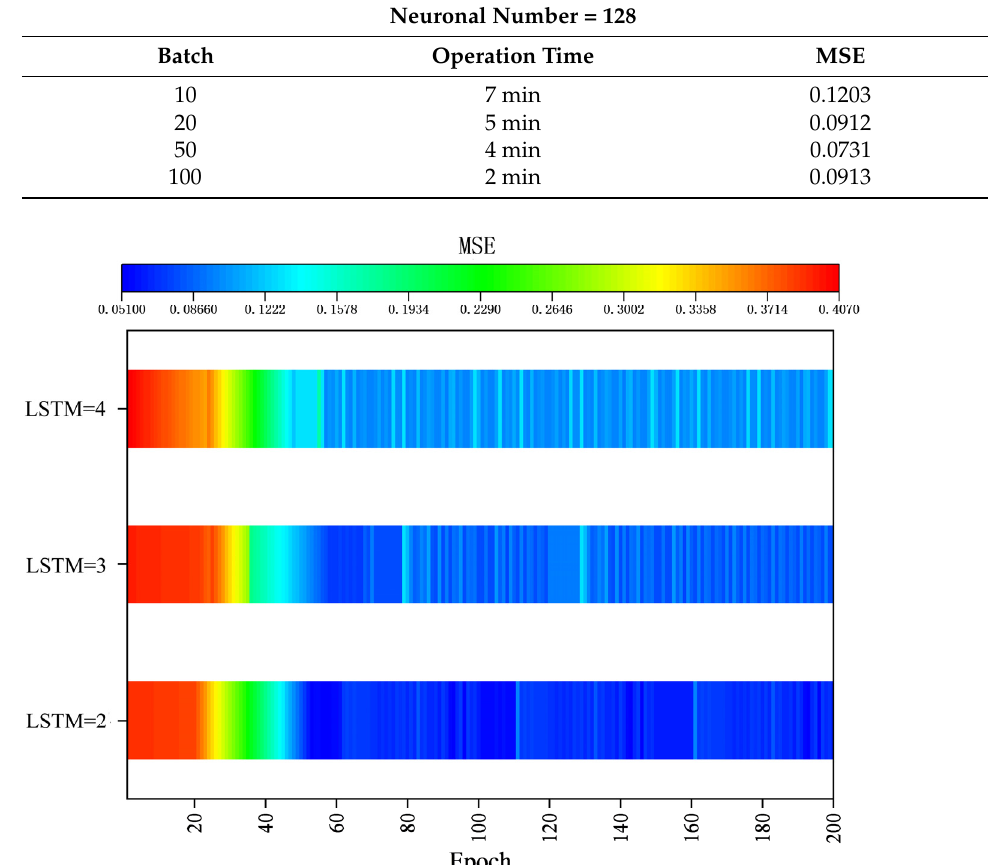
Figure 7. Comparison of LSTM layer number fitting effects. Figure 6 shows the results of the comparative analysis of the loss values for different layers. From Figure 6, it can be seen that the two-layer LSTM continues to maintain a low loss value range during the iterative process, with no significant fluctuations compared to the three- and four-layer LSTMs. Figure 7 shows the fitting results with different numbers of layers. The prediction results of the three- and four-layer models are slightly higher than the actual values, but the prediction results of two-layer LSTM are closer to the real data values. Table 3 shows that the two-layer LSTM has the shortest runtime and the